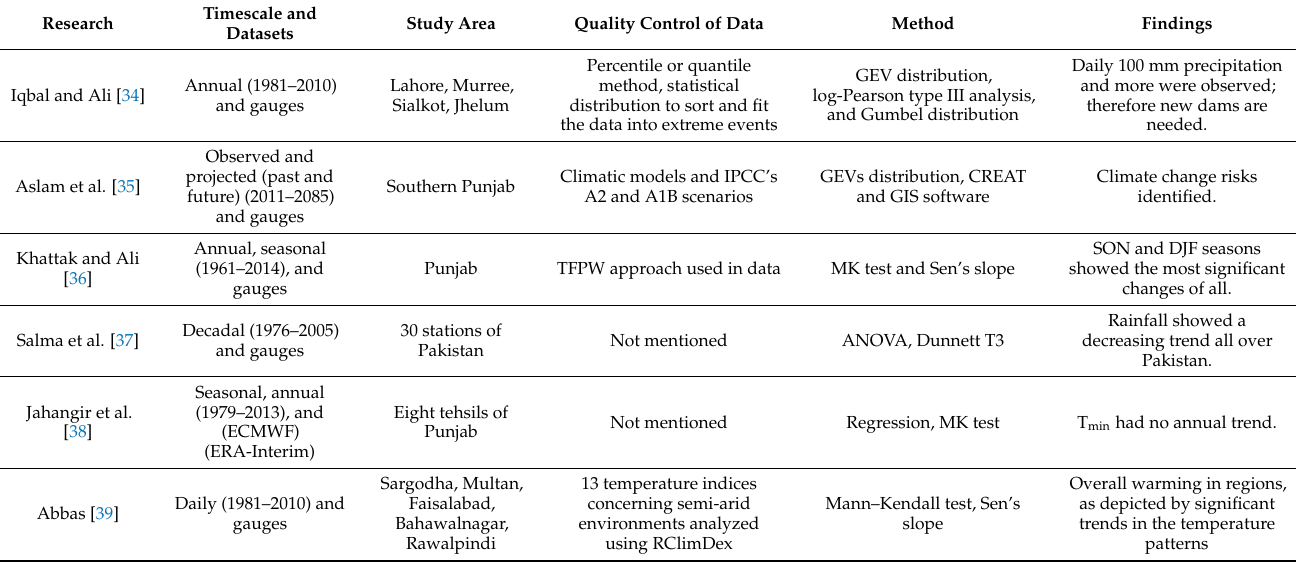
Table 1. A comprehensive outline of the previous studies on the climatic trends of Punjab,